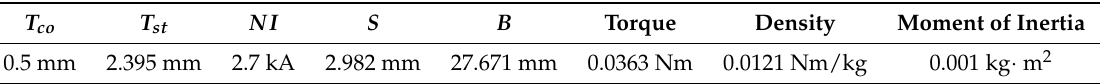
Figure 10. Design parameters optimization by interior point method for better output torque. Table 4. Constrained optimization results by interior point